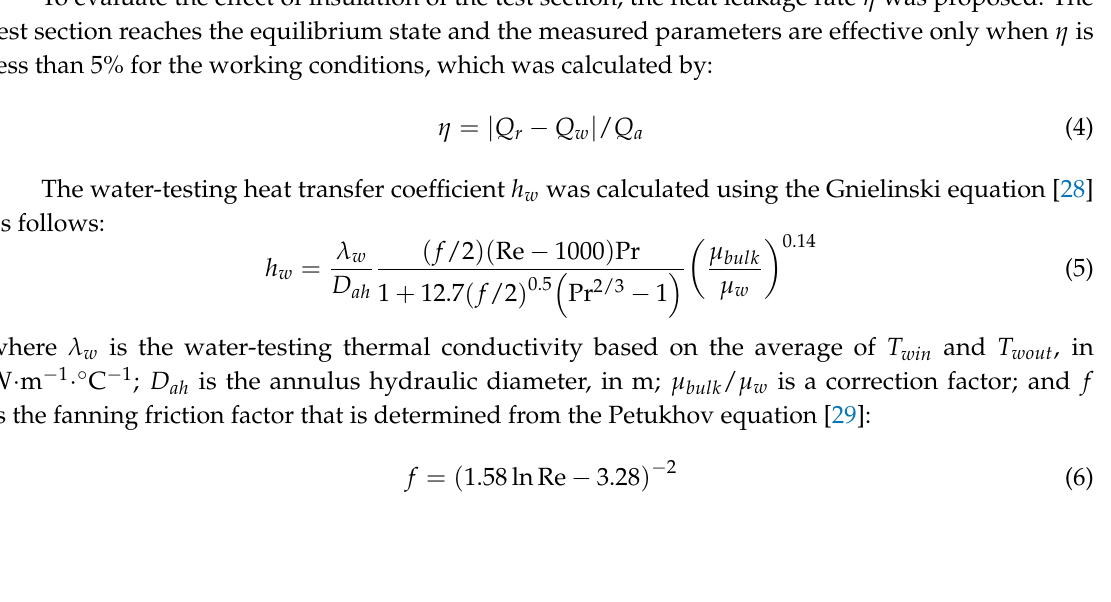
Figure 3. ( a ) Temperature-measuring module and ( b ) pressure-measuring module.